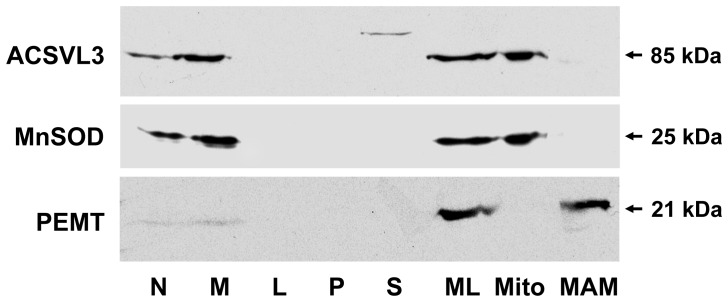
ACSVL3 localization in HepG2 cell subcellular fractions.HepG2 cells were fractionated into nuclear (N), mitochondrial (M), light mitochondrial (L), microsomal (P), and cytosolic (S) fractions by differential centrifugation, and a total mitochondrial (ML) fraction was further separated into purified mitochondrial (Mito) and mitochondria-associated membrane (MAM) fractions, as described in Methods. Each lane was loaded with ∼30 µg protein. Western blot analyses of the same membrane were performed using antibodies against ACSVL3, the mitochondrial marker Mn-superoxide dismutase (MnSOD), and the MAM marker phosphatidylethanolamine N-methyltransferase (PEMT).